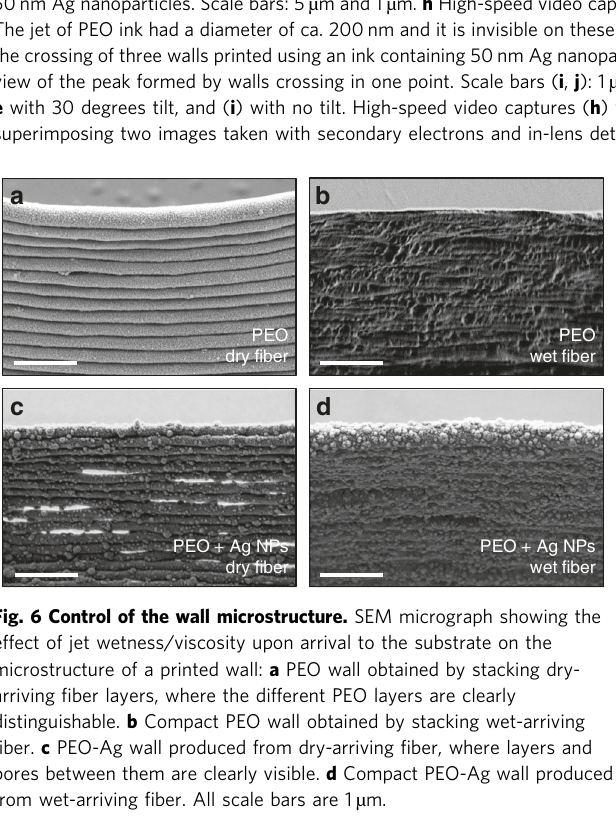
Fig. 5 Printing 3D structures. a Schematic of the 3D printing of a cylinder. b – d SEM micrographs at different magni fi cations of PEO 3D cylindrical microstructures manufactured by EHD jet de fl ection printing. Scale bars ( b – d ): 200 µ m, 5 µ m and 1 µ m. e SEM micrograph of a single suspended PEO fi ber bridging a gap between 2 parallel nanowalls. Scale bar: 2 µ m. f, g SEM micrographs of a PEO-Ag cylindrical structure printed using an ink containing 5 wt% 50 nm Ag nanoparticles. Scale bars: 5 µ m and 1 µ m. h High-speed video captures displaying the growth of a cylindrical structure at a frequency of 200 Hz.